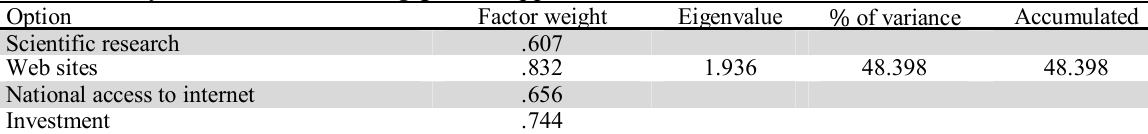
The summary of factors influencing growth opportunities Option